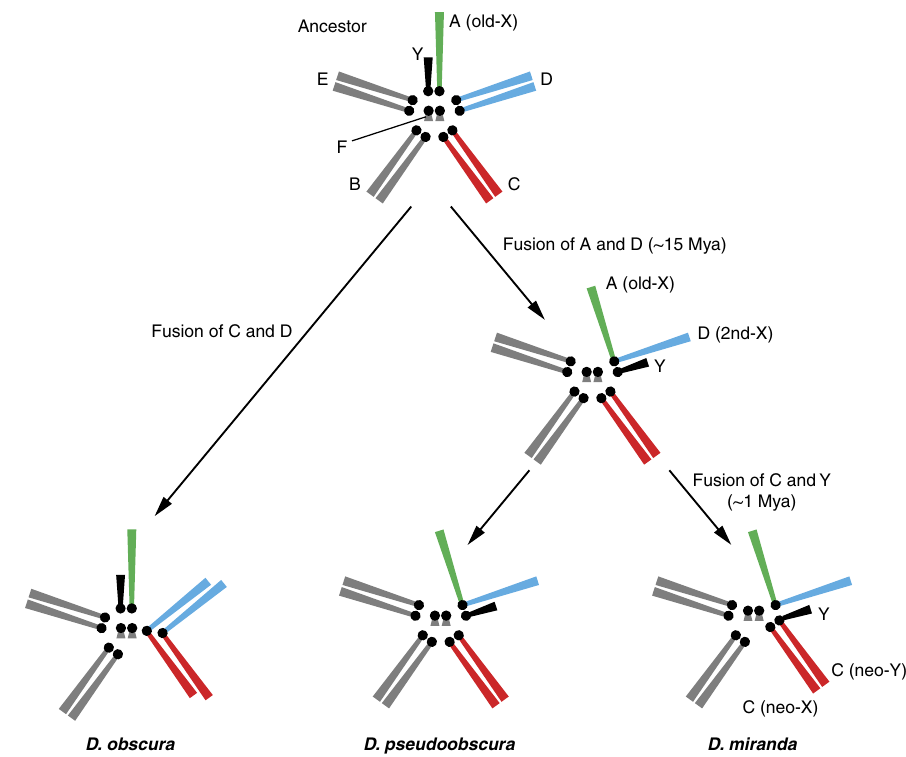
Figure 1 | Evolution of karyotypes in Drosophila miranda and its closely related species. Male karyotypes are shown. In D. obscura (as well as in the common ancestor of these three species), only the Muller element A is the X, whereas in D. pseudoobscura the Muller element D is also X (2nd-X or XR). In D. miranda , the Muller element C additionally became the neo-sex chromosomes. More specifically, one of the pairs was fused with Y, and the other consequently became the neo-X. In other words, D. miranda has three X chromosomal arms with different ages. Grey bars represent autosomes, whereas green bars are the old-X. Blue bars indicate the 2nd-X or its orthologous autosomes. Red bars represent the neo-X, neo-Y, or its orthologous autosomes. Black bars are Y chromosomes. Black dots indicate the rough positions of